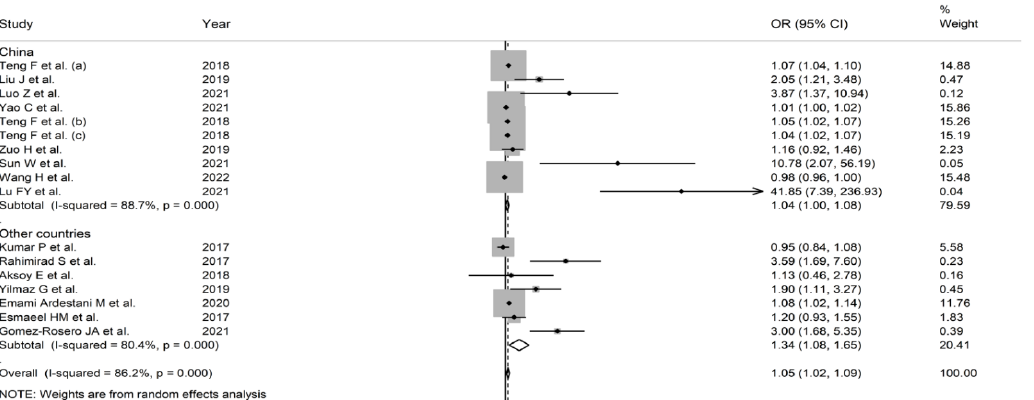
Figure 6. Forest plot of the association between the neutrophil-to-lymphocyte ratio, using odds ratios, and adverse outcomes according to the country where the study was performed (China vs. other countries). p = 0.000 indicates a p -value < 0.001.